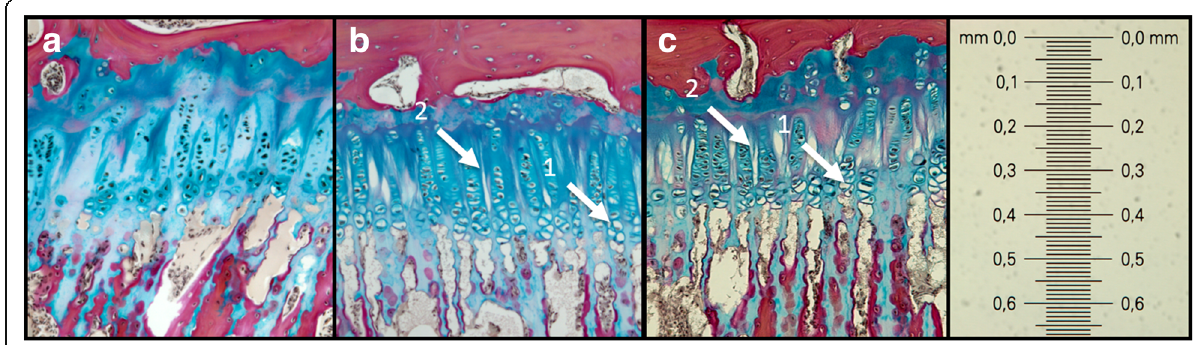
Fig. 5 Visualization of the histological results. Control ( a ), flexion ( b ) and extension ( c ) FSUs, where the reduction of intracellular content (1) and extracellular matrix (2) are highlighted with white arrows . Sizebar in mm. Haematoxylin-eosin and Alcian blue solution